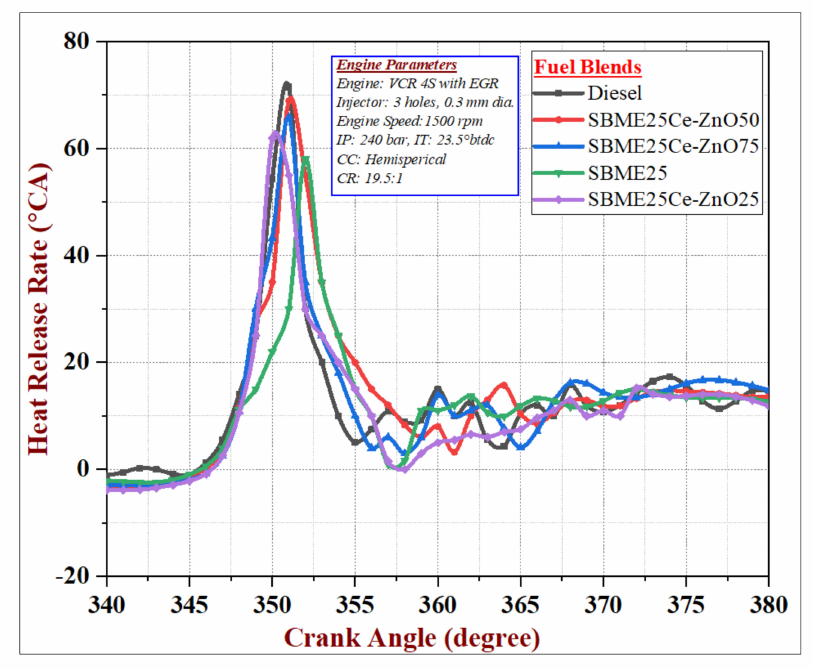
Figure 14. Variation of HRR at di ff erent crank